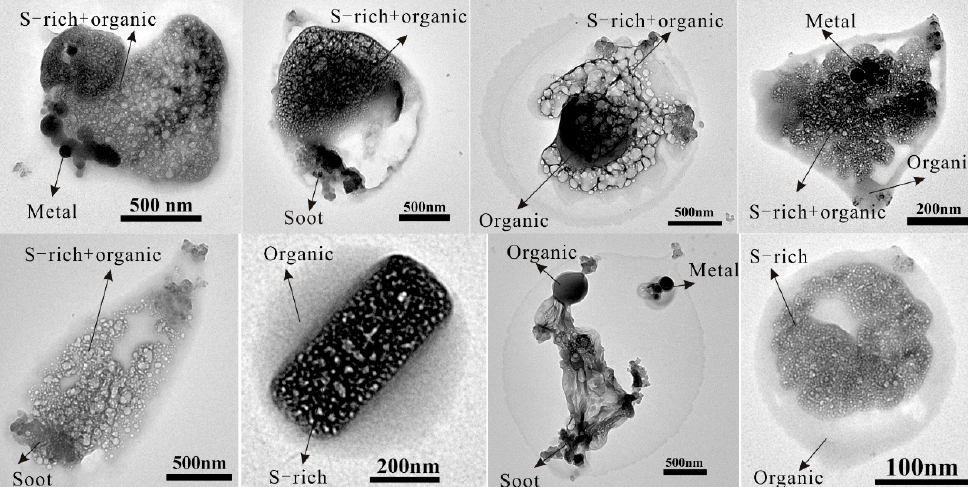
Figure 3. Morphology and compositions of mixture particles at the roadside site.